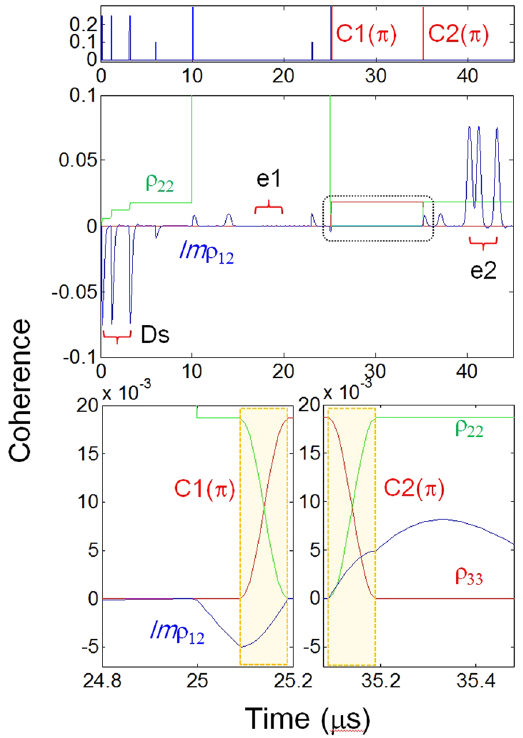
Figure 6. Storage time extended CASE. Top panel: Pulse sequence for multiple data storage. Middle panel: Storage time extension. Bottom panel: Coherence inversion (expansion of the dotted box in the middle panel). All parameters are the same as in Fig. 5 except for the splitting of C into C1 and